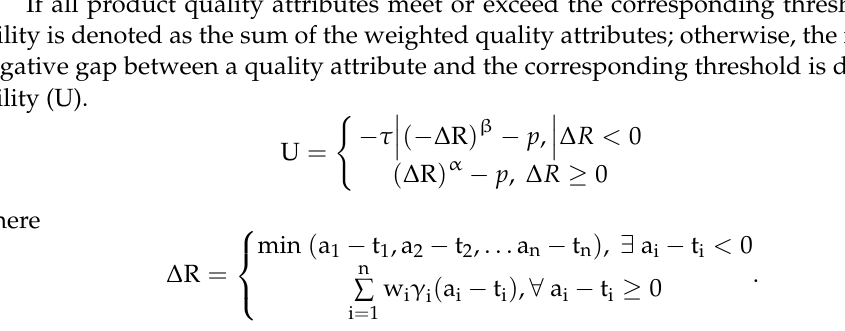
Figure 4. Conceptional relationship diagram of consumer adoption.